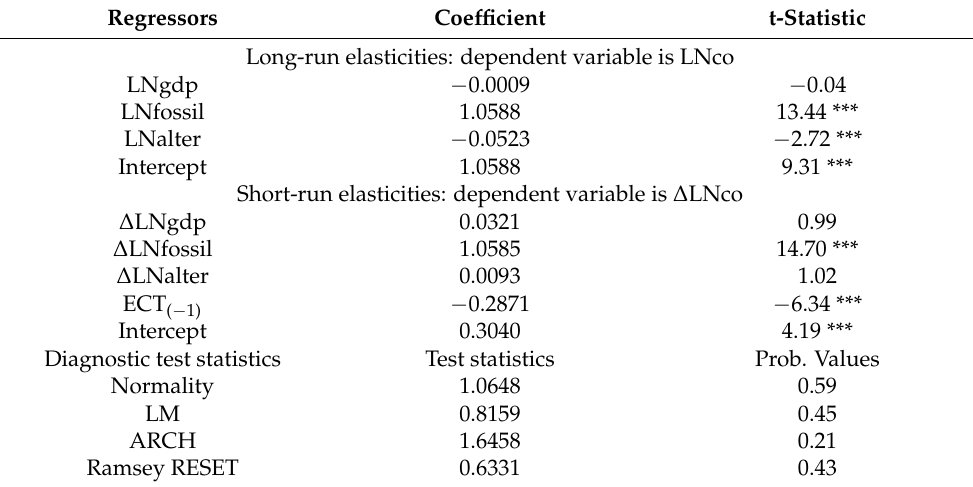
Table 4. Estimated coefficients from ARDL (1,0,1,2)